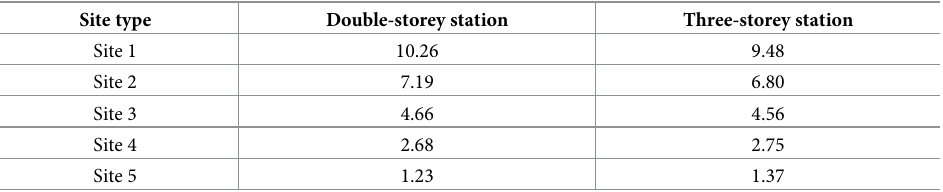
Table 4. Soil-structure stiffness ratio F of different site soil conditions.